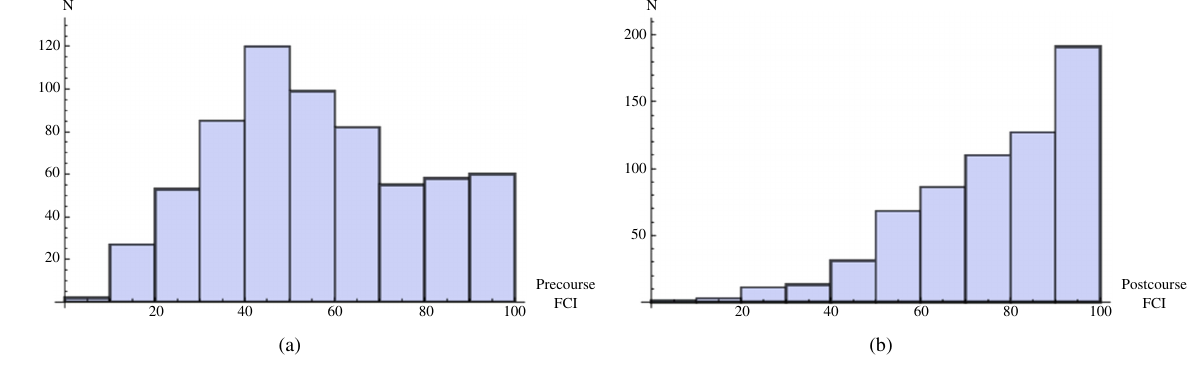
FIG. 1. (a) Precourse and (b) postcourse FCI scores for “ matched ” students.